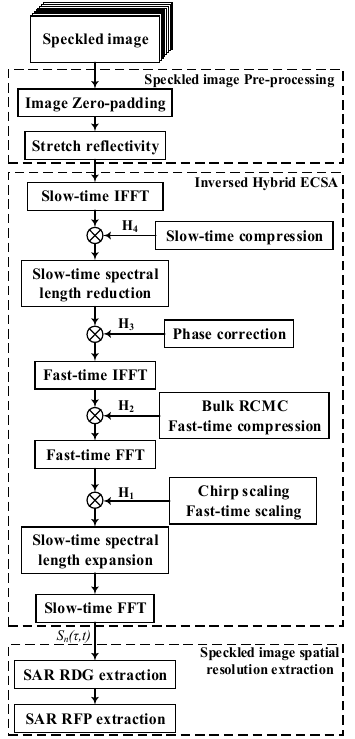
Figure 6. Proposed system resolution extraction algorithm with the help of range cell migration cancellation (RCMC).